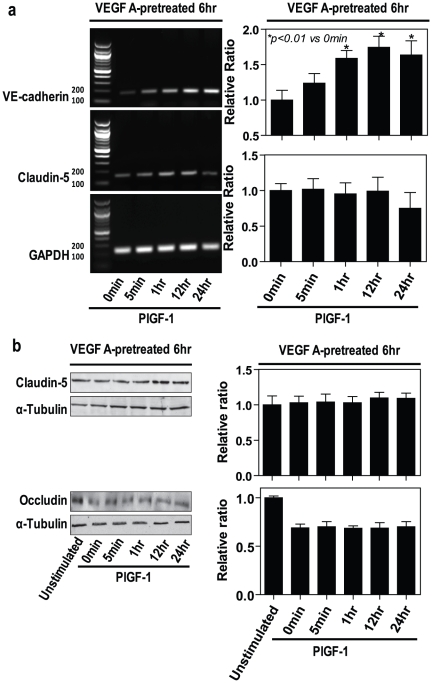
PlGF-1 does not regulate the expression of the TJ proteins claudin-5 or occludin.(a) Confluent microvascular endothelial cultures were exposed to VEGFA followed by hPlGF-1 6 hours later for varying times and VE-cadherin and claudin-5 mRNA levels quantified using QRT-PCR. VEGFA and hPlGF-1 were used at 100 ng/ml. Values are displayed as mean transcript copies normalized against GAPDH as the housekeeping gene (n = 3). (b) Using the same experimental conditions, claudin-5 and occludin expression were assessed by Western blot. Left, representative immunoblots for claudin-5 and occludin and, upon reblot, α-tubulin. Bottom, laser densitometry analysis demonstrating the relative ratio of claudin-5 and occludin to the house keeping protein α-tubulin (n = 3). Data are represented as means ± s.e.m. *p<0.05, ** by p<0.01 (Mann-Whitney U test).